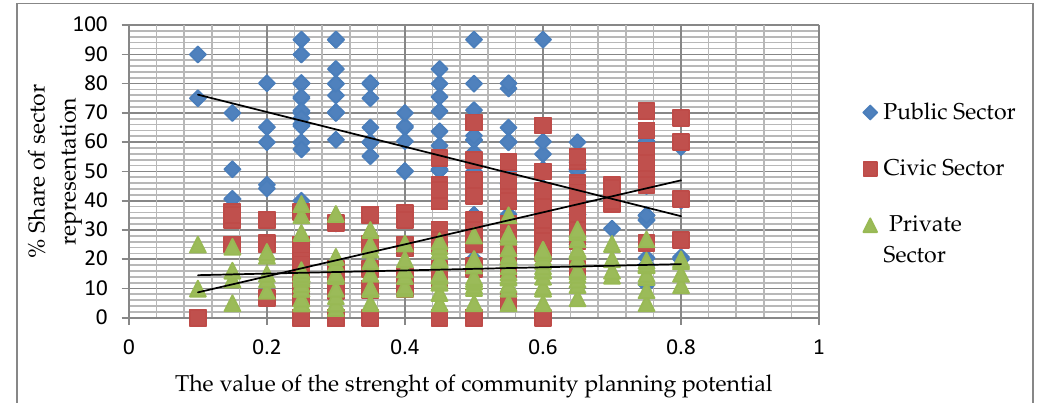
Figure 4. Linear line—comparison of the impact of the sectors on the KPSS potential. Source: Own processing.